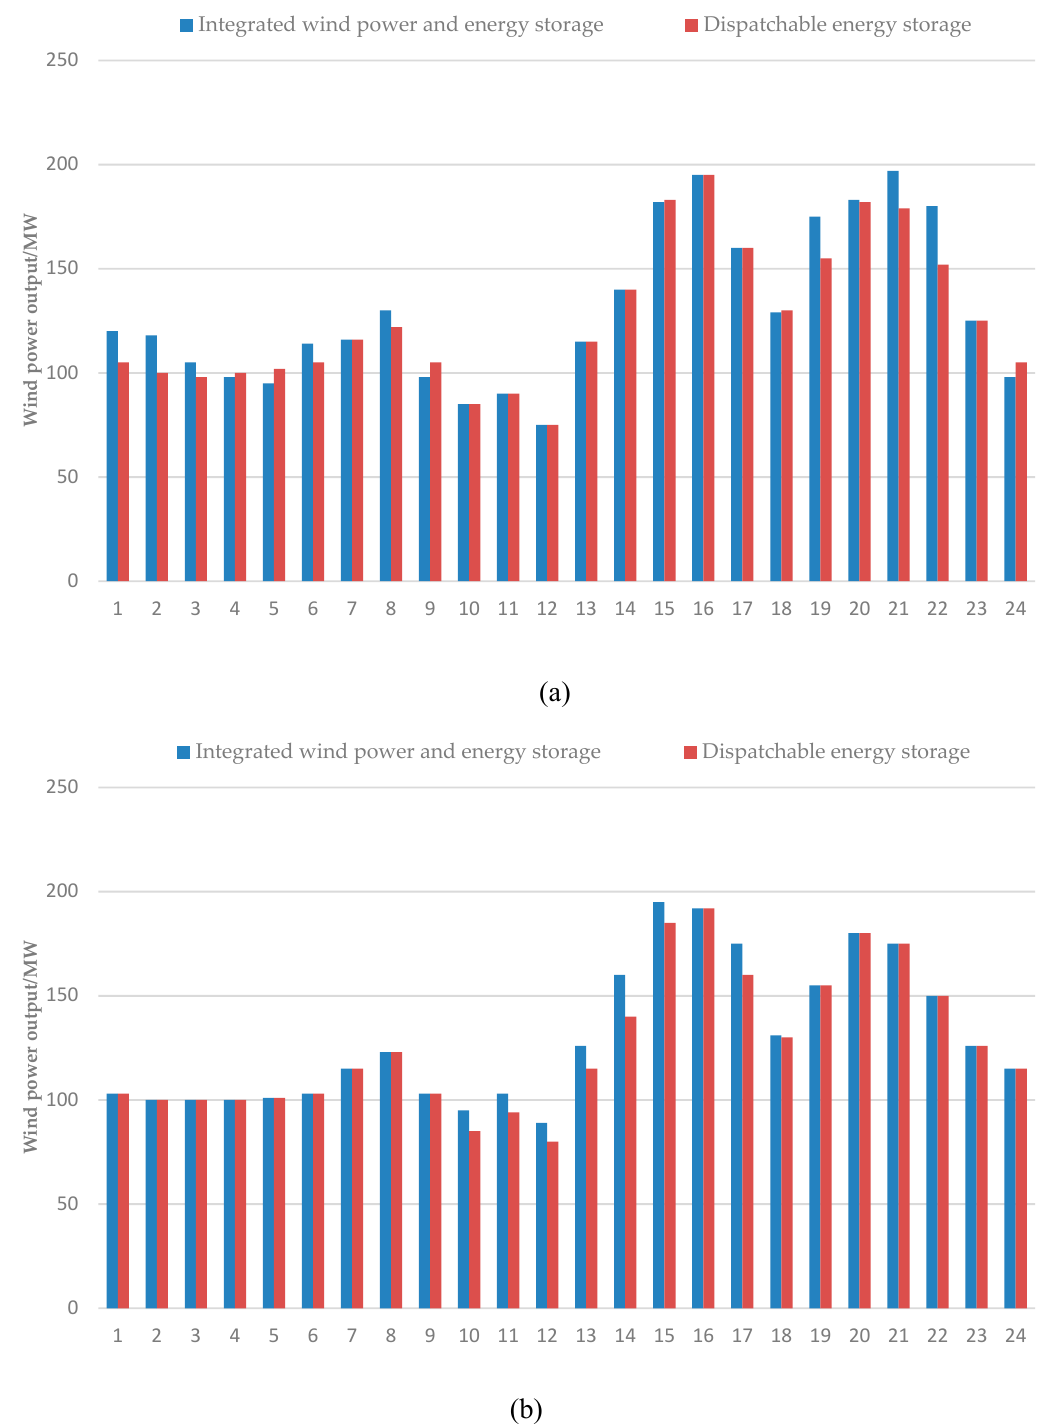
Figure 10. Every period of wind power and power of wind power station of two kinds of wind power and energy storage in combined operation mode.